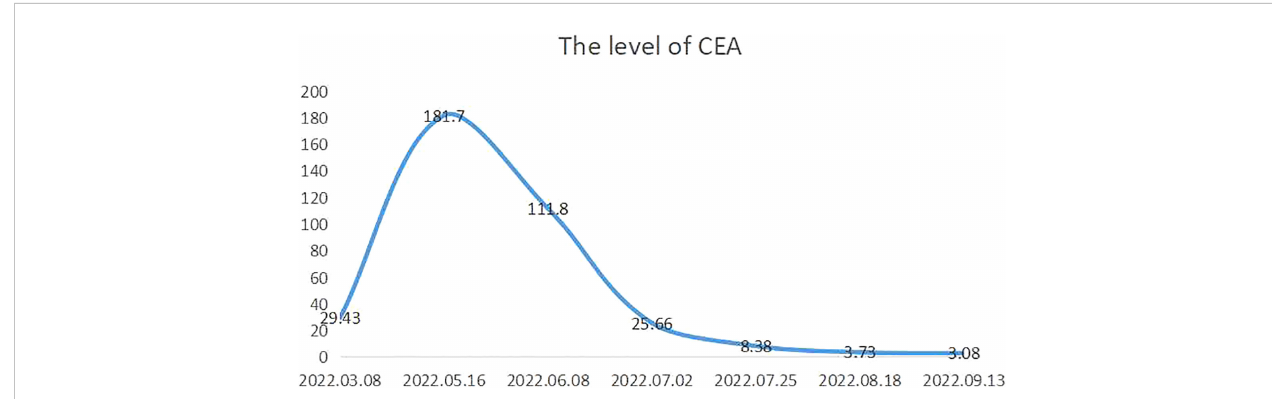
FIGURE 3 Carcinoembryonic antigen levels during treatment.